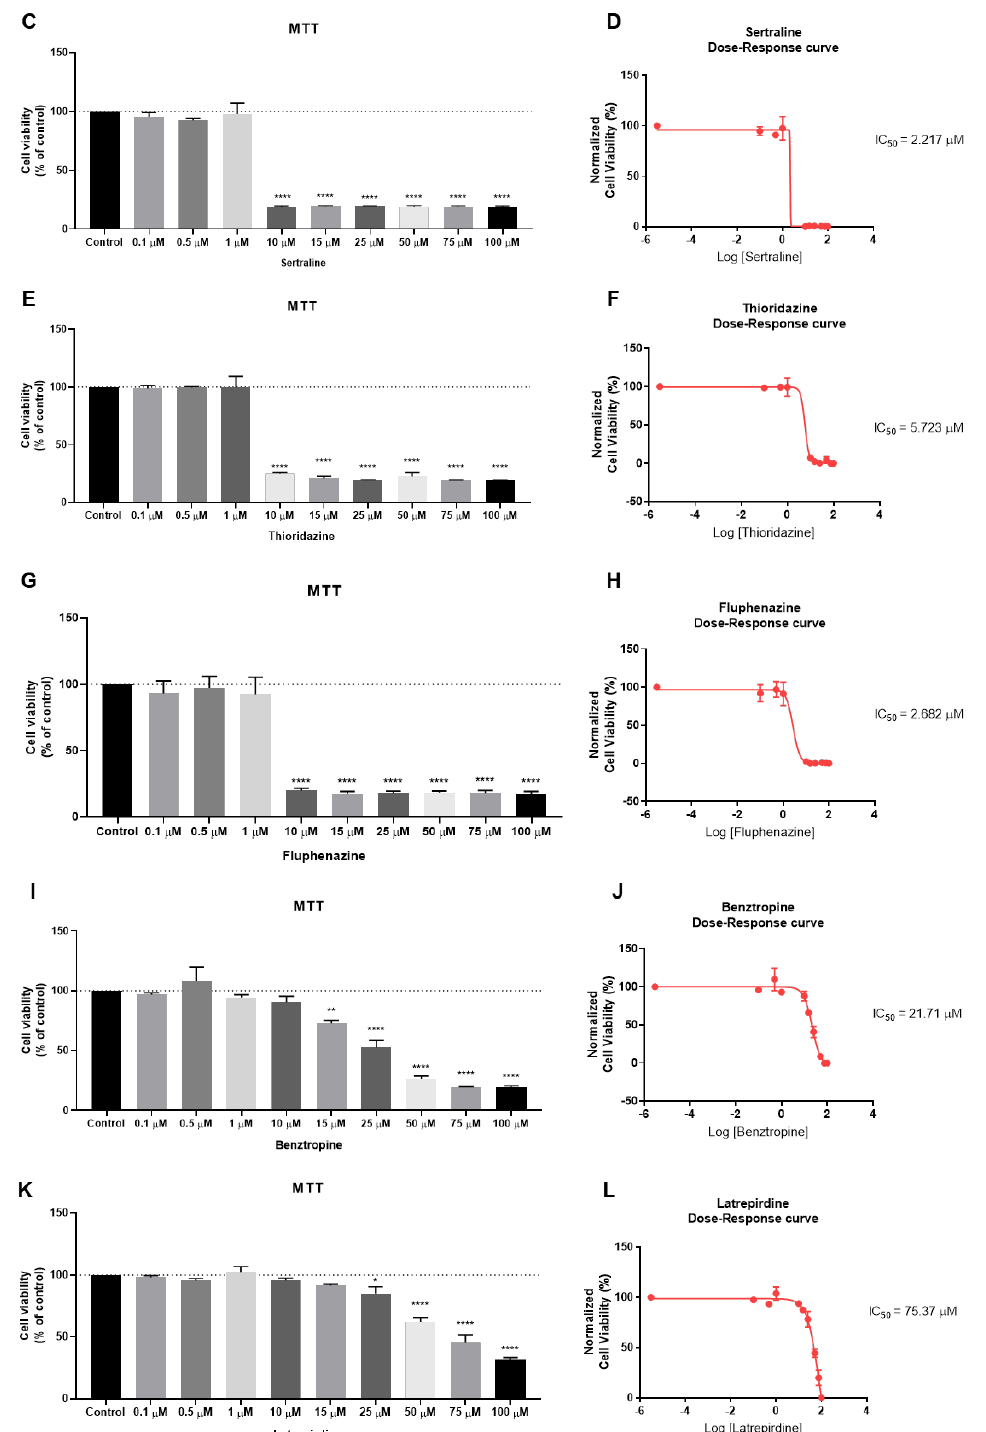
Figure 14. The effects of some CNS drugs on MCF-7 cells. ( A ) The effect of fluoxetine on cell viability and ( B ) the dose- response curve. ( C ) The effect of sertraline on cell viability and ( D ) dose-response curve. ( E ) The effect of thioridazine on cell viability and ( F ) the dose-response curve. ( G ) The effect of fluphenazine on cell viability and ( H ) the dose-response curve. ( I ) The effect of benztropine on cell viability and ( J ) the dose-response curve. ( K ) The effect of latrepirdine on cell viability and ( L ) the dose-response curve. Cells were cultured in the presence of increasing concentrations of each drug, and after 48 h, the MTT assay was performed to measure the cellular viability. Values are expressed in percentage of control and represent means ± SEM. Each experiment was done three times independently ( n = 3); * statistically significant vs. control at p < 0.05. ** statistically significant vs. control at p < 0.01. **** statistically significant vs. control at p <